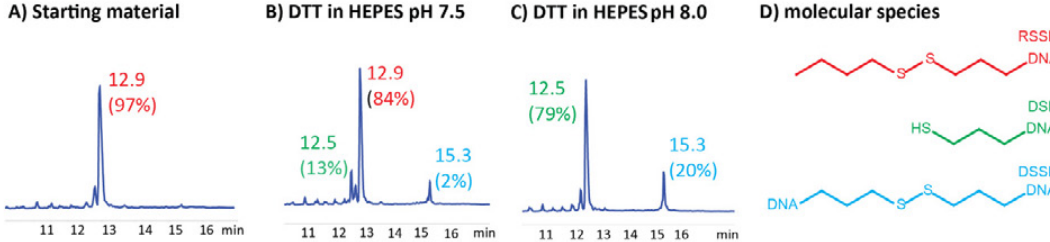
Fig. 3. Formation of thiolated reduced DNA and oxidized dimer DNA. A) Starting material, RSSD, protected thiolated DNA with a disulfide bond. B) The results of incubation of the sample with 50 mM DTT in presence of 50 mM HEPES buffer pH 7.5 for 60 min. C) The results of incubation of the sample with 50 mM DTT in presence of 50 mM HEPES buffer pH 8.0 for 60 min. in B and C DTT was removed prior to HPLC. D) Schematic representation of the starting material, RSSD (red), the desired thiolated reduced DNA, DSH (green) and the side product dimer of DNAs, DSSD (blue). The same color codes are valid through all chromatograms of this report. In this figure, retention times are depicted with the same color code as in D, above each peak. The numbers in parenthesis indicate the percentage of each peak over total